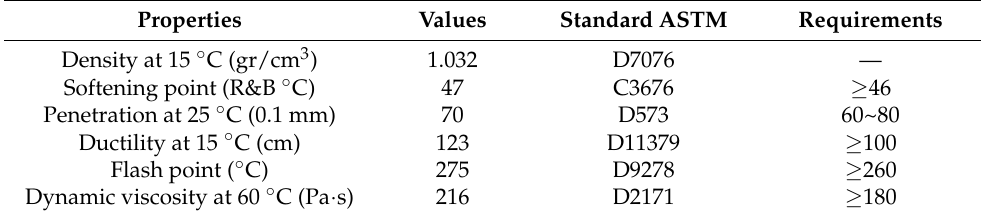
Table 3. Performance test results of 70 penetration